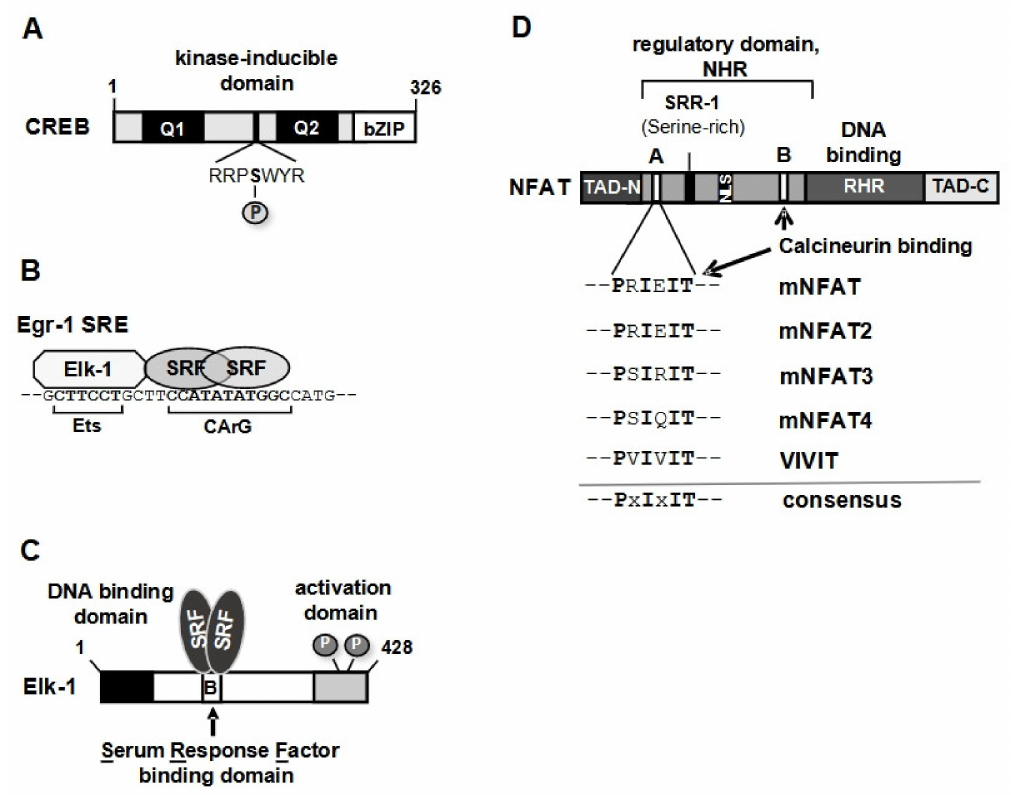
Figure 2. Ca 2+ -responsive transcription factors. ( A ) Modular structure of CREB (cyclic AMP-response element (CRE)- binding protein). The basic region leucine zipper (bZIP) domain, used for dimerization and DNA binding, is located at the C -terminus. CREB contains a phosphorylation-dependent transcriptional activation domain (kinase-inducible domain, KID) and two constitutively active glutamine-rich activation domains (Q1 and Q2). The phosphorylation site within the KID is depicted. ( B ) The serum-response element (SRE) provides binding sites for the ternary complex factor Elk-1 and for SRF (serum response factor). SRF binds as a dimer to the consensus sequence CC[A/T] 6 GG, known as CArG box. Elk-1 binds to a DNA motif with the consensus core sequence GGAA/T, called Ets site, because Ets (E26 transformation-specific) transcription factors interact with this DNA sequence. ( C ) Modular structure of Elk-1, showing the N -terminal DNA binding domain, the C-terminal activation domain with the key phosphorylation sites and the B domain that is required for interaction with the SRF dimer. ( D ) Modular structure of NFAT transcription factors. The transcriptional activation domains (TAD), the regulatory domain and the DNA binding domain are depicted. The binding sites for calcineurin are indicated. The sequences of the major binding sites of calcineurin to the NFAT proteins, the consensus site and the optimal binding site (VIVIT) are